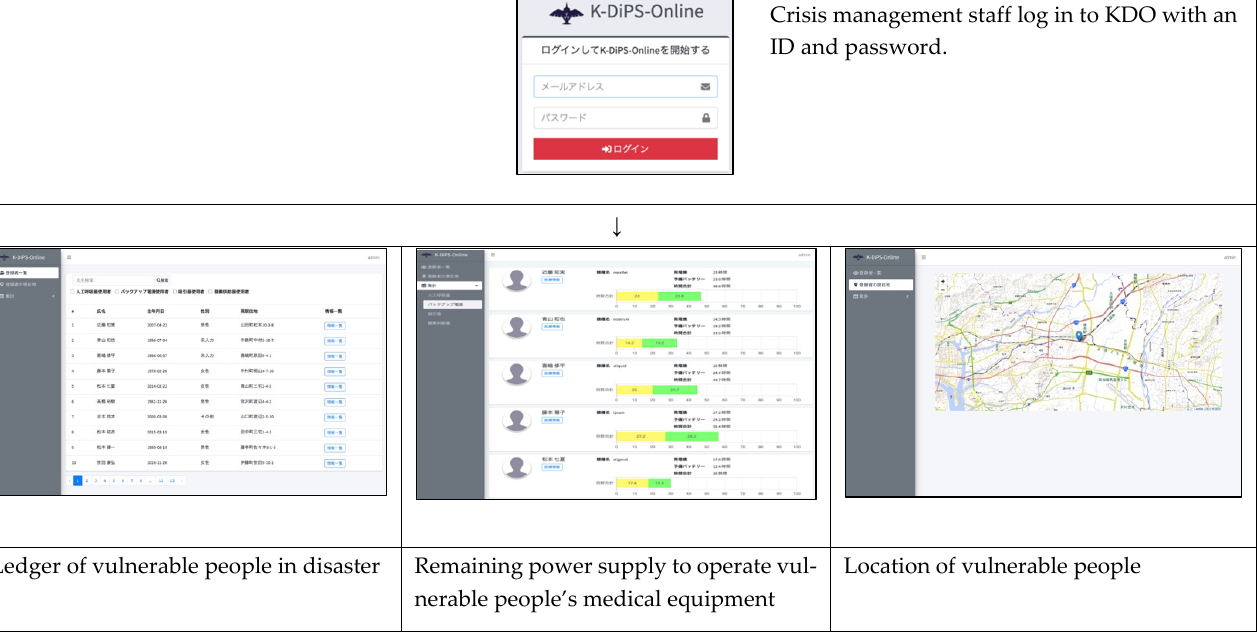
Figure 7. Screenshots of “Ledger of vulnerable people in disaster,” “Remaining amount of backup power supply,” and “Display of users’ whereabouts” in KDO.